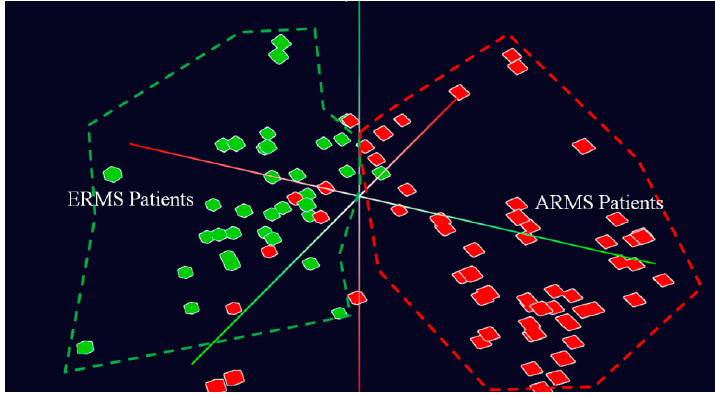
Figure 6. An example of a top-level 3D graph with a colour filter applied to two distinct types of patients, including Rhabdomyosarcoma Alveolar (ARMS) (red colour) and Embryonal RMS (ERMS) (green colour).